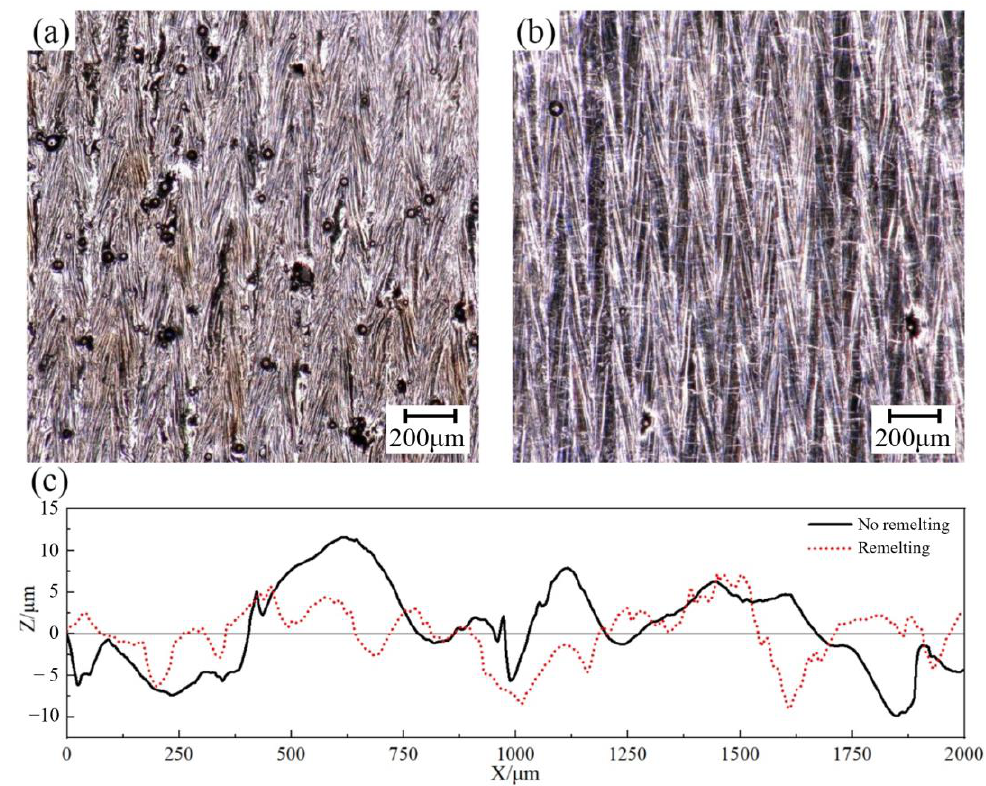
Figure 14. Macroscopic morphology of upper surface before and after remelting: ( a ) no remelting; ( b ) remelting; ( c ) comparison of surface profile curves.